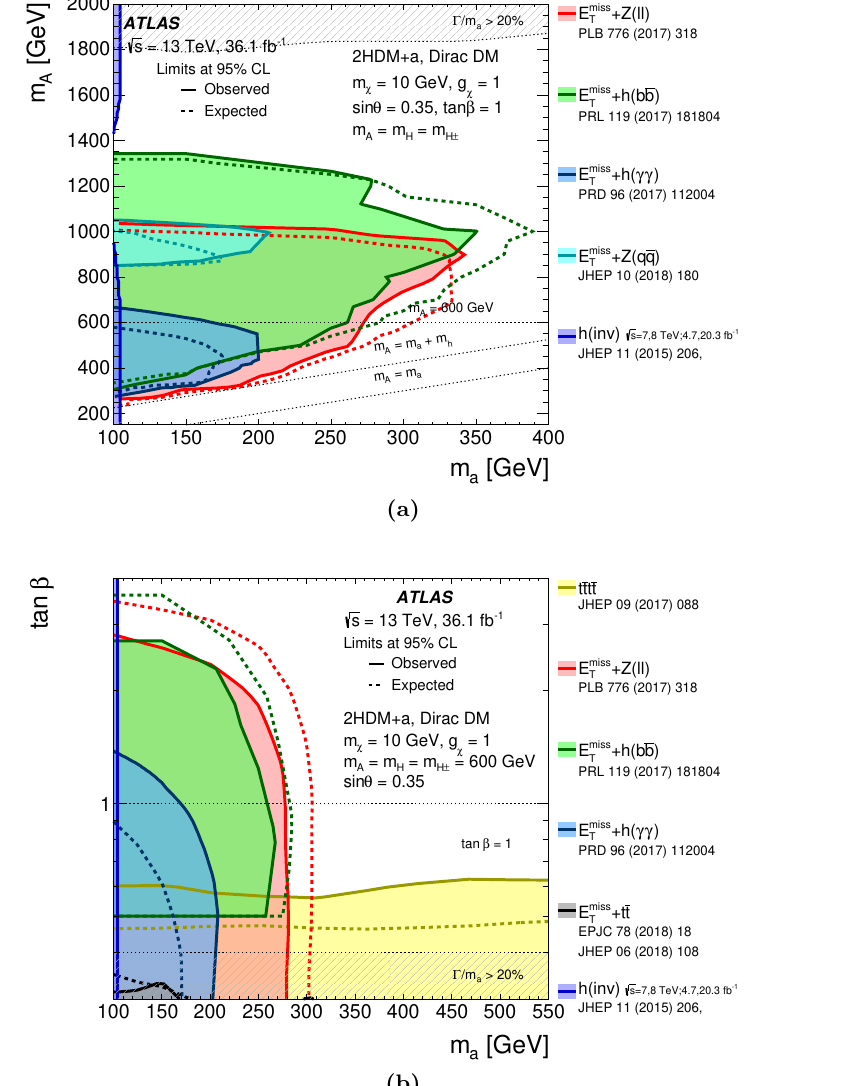
Figure 19. Regions in the (a) ( m a ; m A ) and (b) ( m a ; tan (cid:12) ) planes excluded by data at 95% CL by and t (cid:22) tt (cid:22) t analyses, following the parameter choices of scenarios 1 and 2 of the 2HDM+ a X + E miss T model. The dashed grey regions at the top of (a) and the bottom of (b) indicate the region where the width of any of the Higgs bosons exceeds 20% of its mass. The exclusion limits presented above conservatively neglect the contribution from b (cid:22) b -initiated production, which might be sizeable for tan (cid:12) 3 for the Z + E miss channel and, to a lesser extent, for the h + E miss T (cid:21)